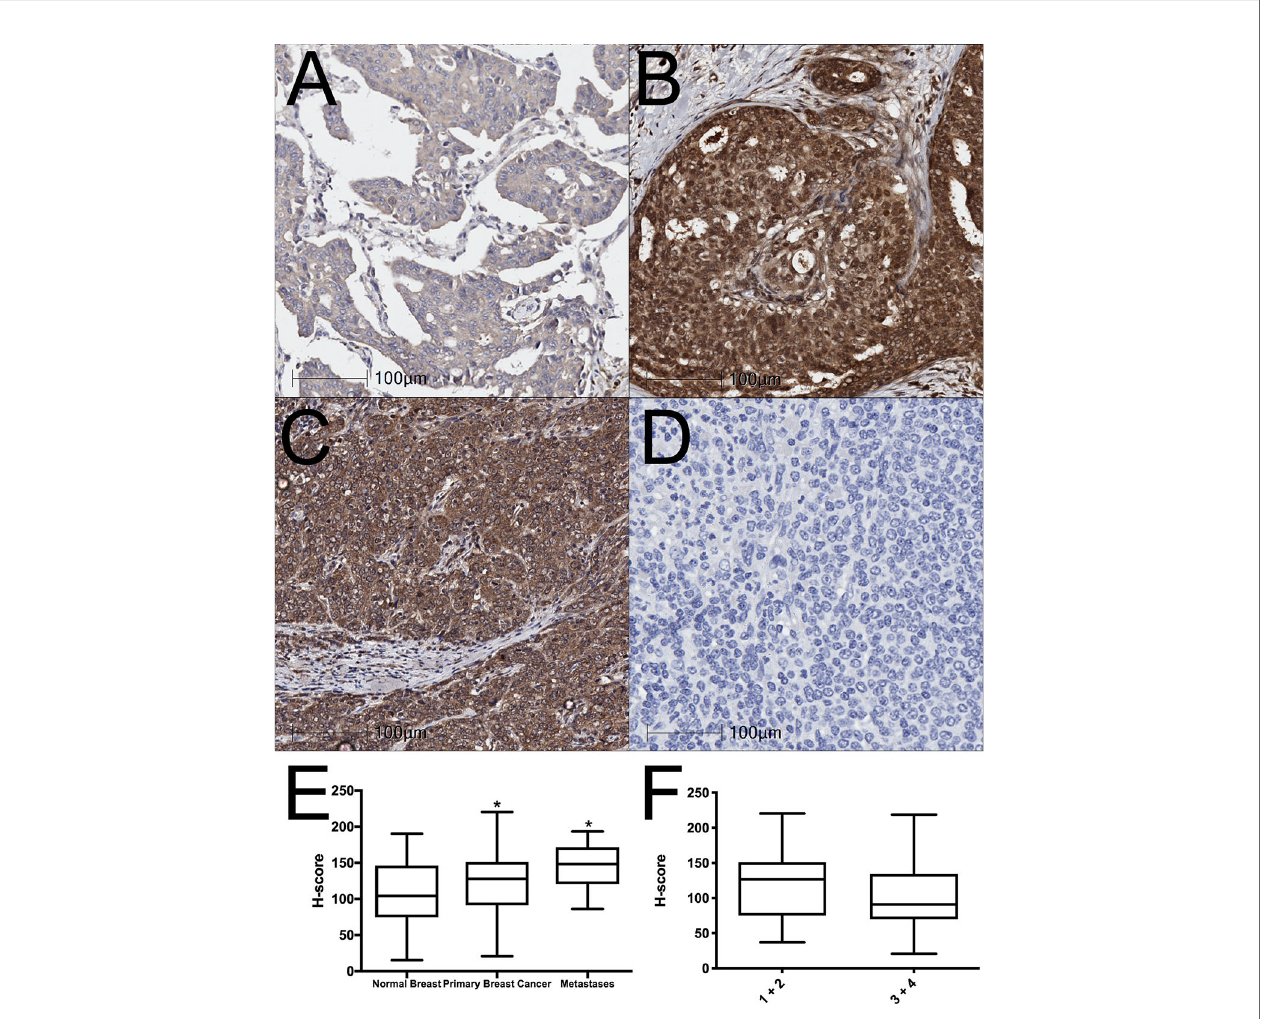
FIGURE 1 | BAALC expression is increased in primary breast cancer and lymph node metastases tissues. (A) Normal breast, (B) primary breast cancer, and (C) lymph node metastases were examined for BAALC expression by immunohistochemistry. (D) Negative control. (E) Staining was quanti fi ed and expressed as an H-score in 70 primary breast cancer, 40 matched normal breast, and 10 lymph node metastases cores, (F) H-score comparison between tumors classi fi ed as Grade 1 + 2 or Grade 3 + 4 from n=70 primary breast cancer in (E) Photomicrographs are representative of each tissue type. * denotes statistical signi fi cance p < 0.05 as determined by one-way